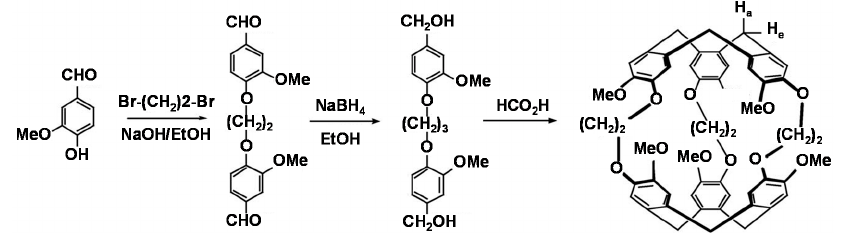
Scheme 1. Synthesis of CrypA.